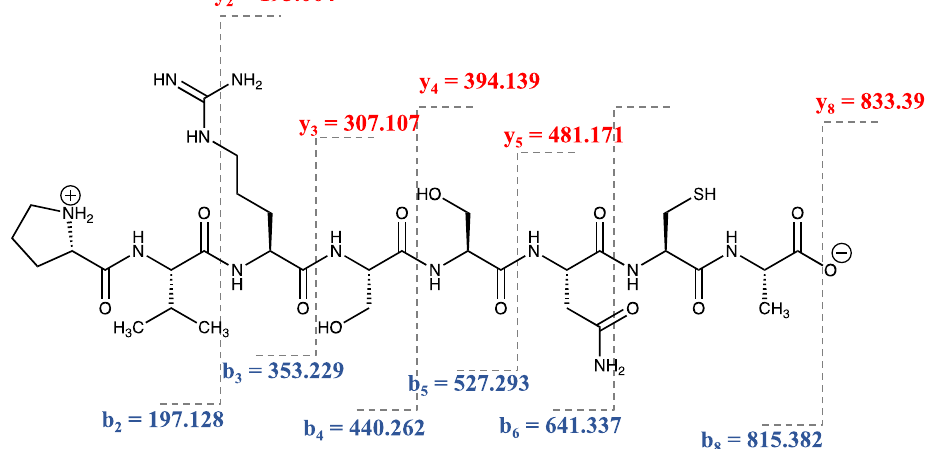
Figure 1. The fragmentation pattern of the highest ion intensity (M + H) + = 832.38; m / z = +1) from the hydrolysate. The fragment ions generated from the peptide sequence align with the spectrum. N-terminal ions (b-ion series) are shown in blue and C-terminal ions (y-ion series) are shown in red. The chemical structure was generated using the ChemDraw 19.1 academic licensed